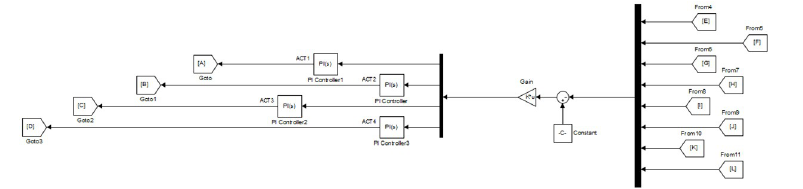
Fig 6. SFG-SISO PI control in